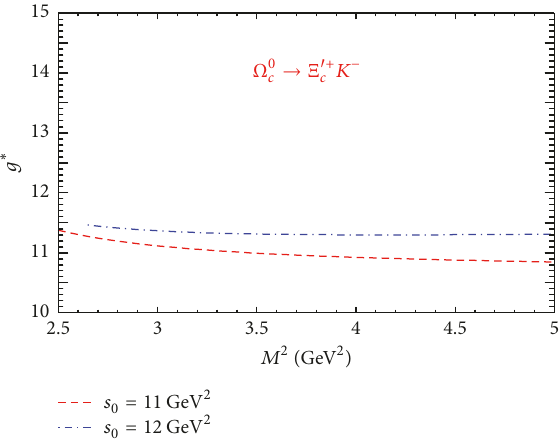
Figure 1: The dependence of the strong coupling constant for Ω 𝑐 → Ξ 󸀠+ 𝐾 transition on 𝑀 2 at two fixed values of 𝑠 𝑐